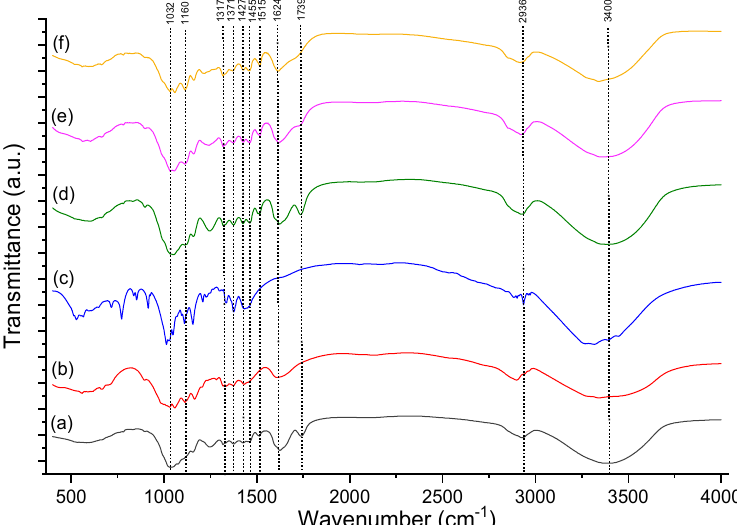
Figure 9. FTIR images of ( a ) raw material, ( b ) cellulose standard, ( c ) glucose standard, ( d ) pretreated biomass at 160 °C for 30 min, ( e ) pretreated biomass at 180 °C for 30 min, and ( f ) pretreated biomass at 200 °C for 30 min .